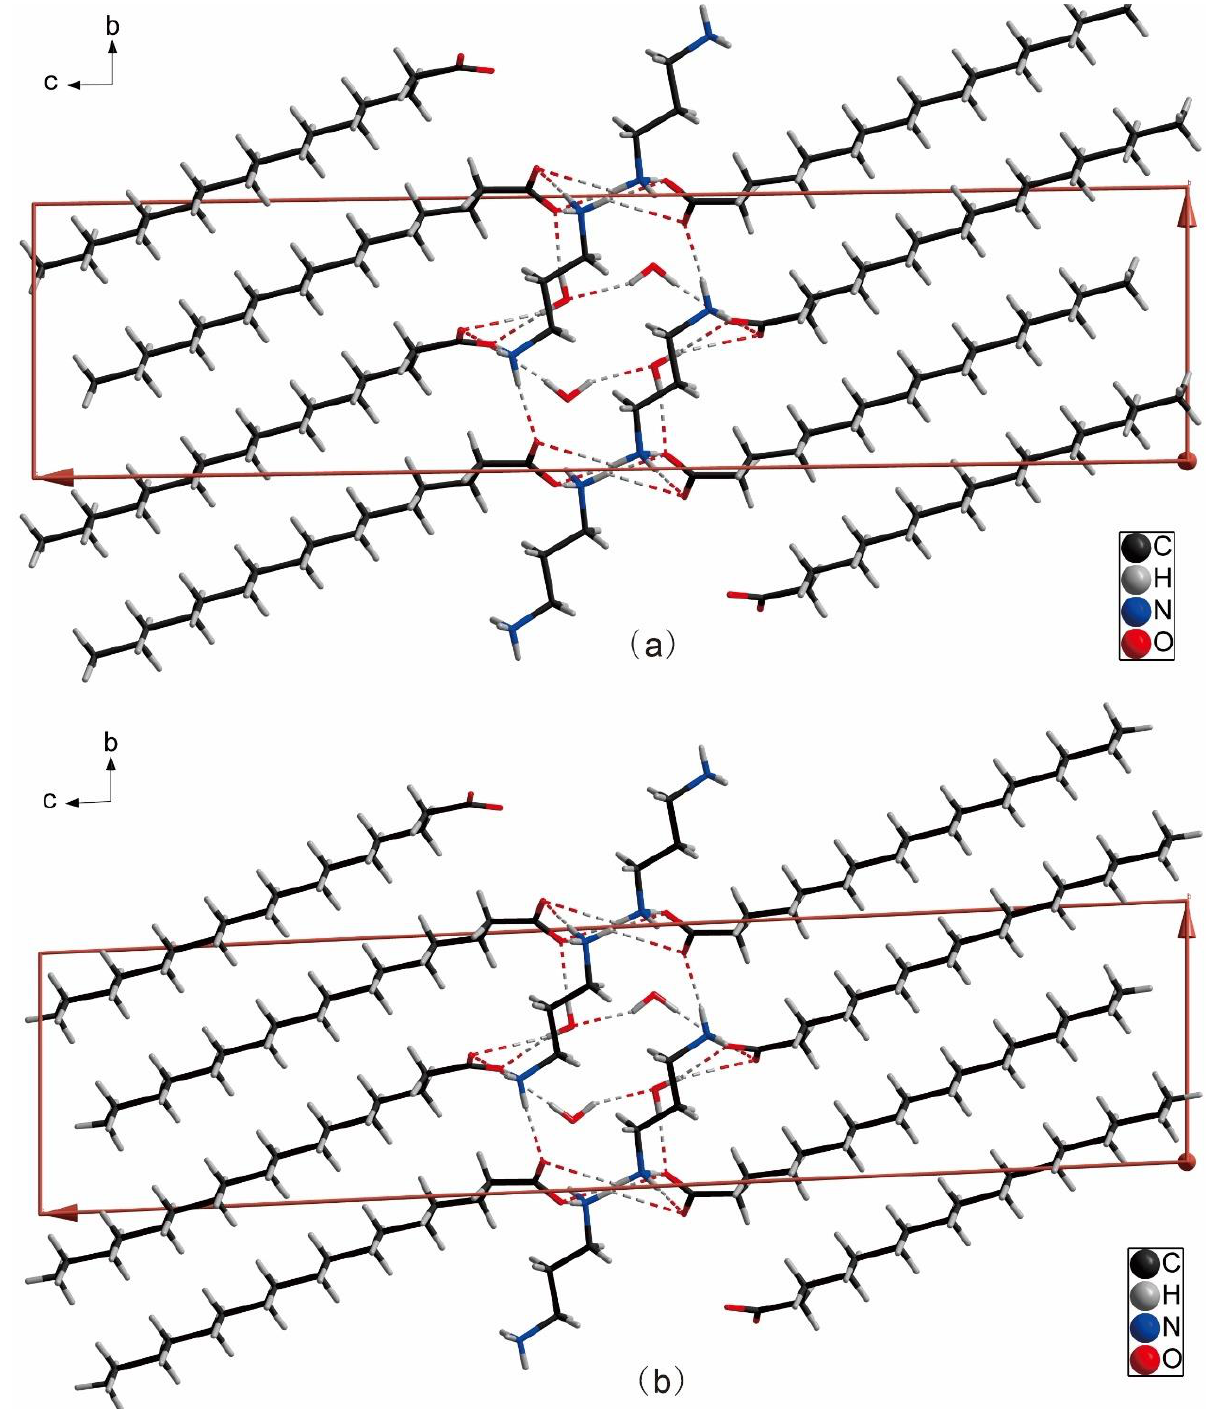
Figure 2. Unit cell diagrams of the two molecules: where ( a ) represents 3C16 and ( b ) represents 3C17.